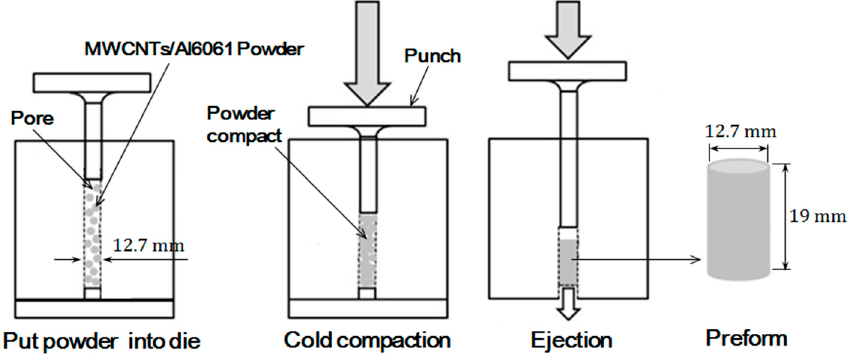
Figure 1. Schematic of the process for preform fabrication by cold-compaction process.